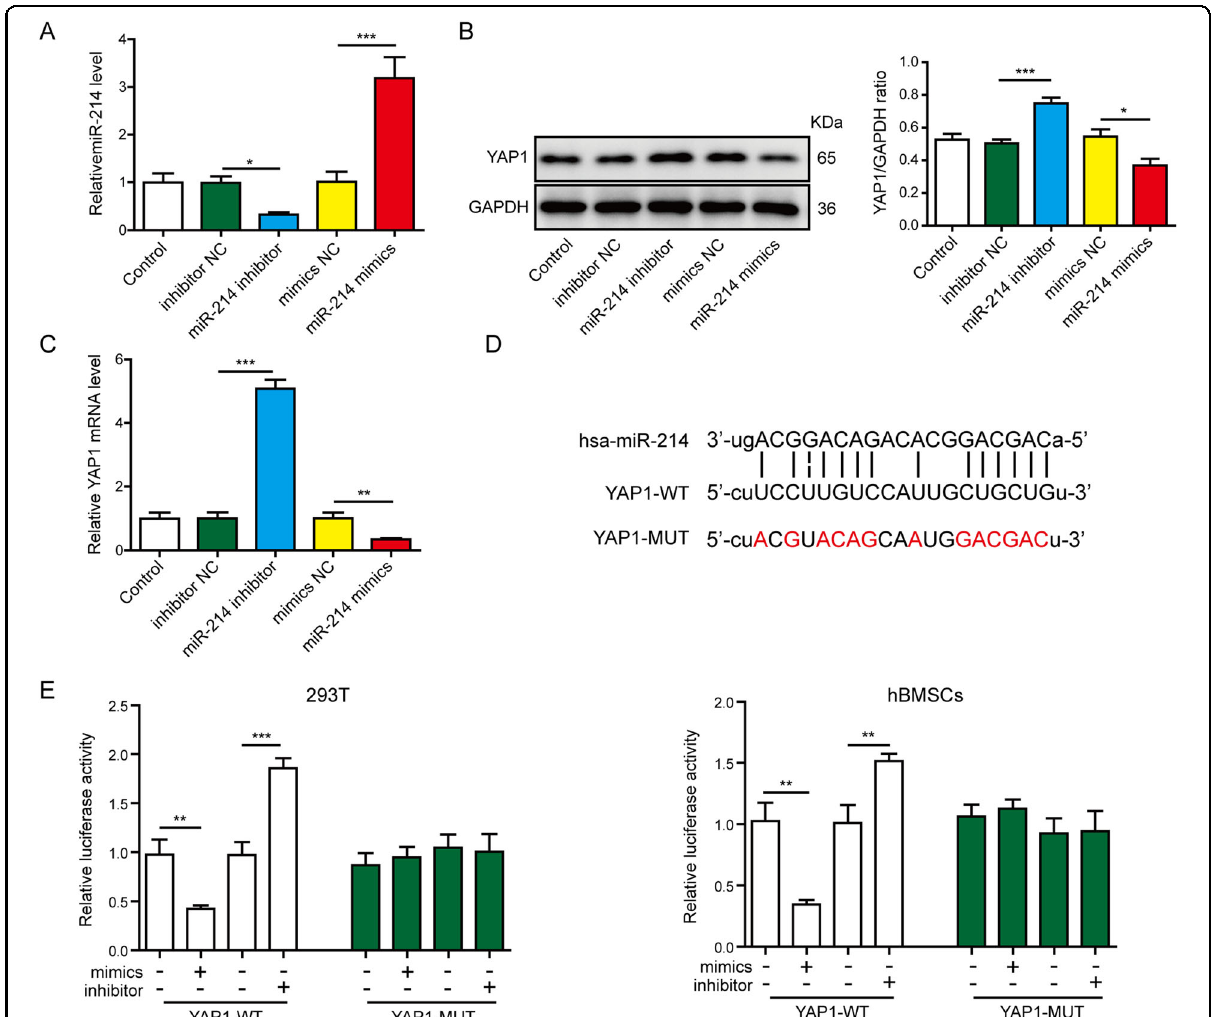
Fig. 5 MiR-214 directly and negatively regulated YAP1 expression. The hBMSCs were transfected with miR-214 mimics, miR-214 inhibitor, or their negative controls for 48 h, then the expressions of miR-214 ( A ) and YAP1 ( B , C ) were measured by RT-qPCR and western blot. D StarBase analysis showed the potential binding sites for miR-214 and YAP1. E Dual-luciferase reporter assay was used to verify the association of miR-214 with YAP1 in 293T cells and hBMSCs. * P < 0.05, ** P < 0.01, and *** P <